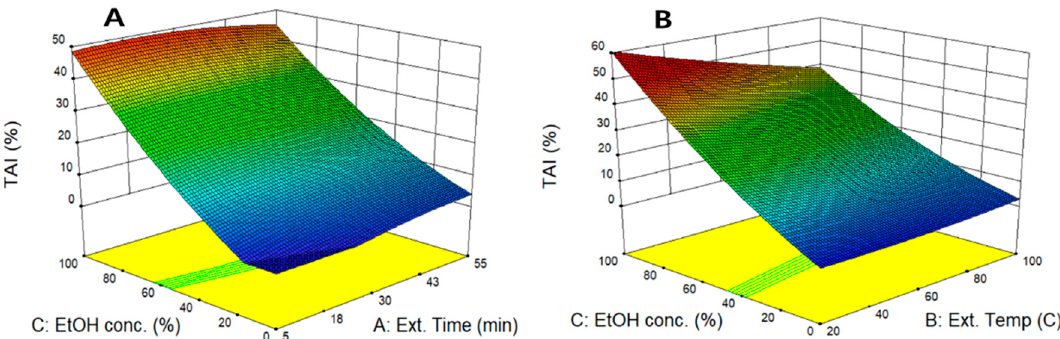
Figure 3. Response surface for TAI in peanut shell extract according to extraction time, extraction temperature, and ethanol concentration. TAI as a function of extraction time and ethanol concentration ( A ), extraction temperature and ethanol concentration ( B ).